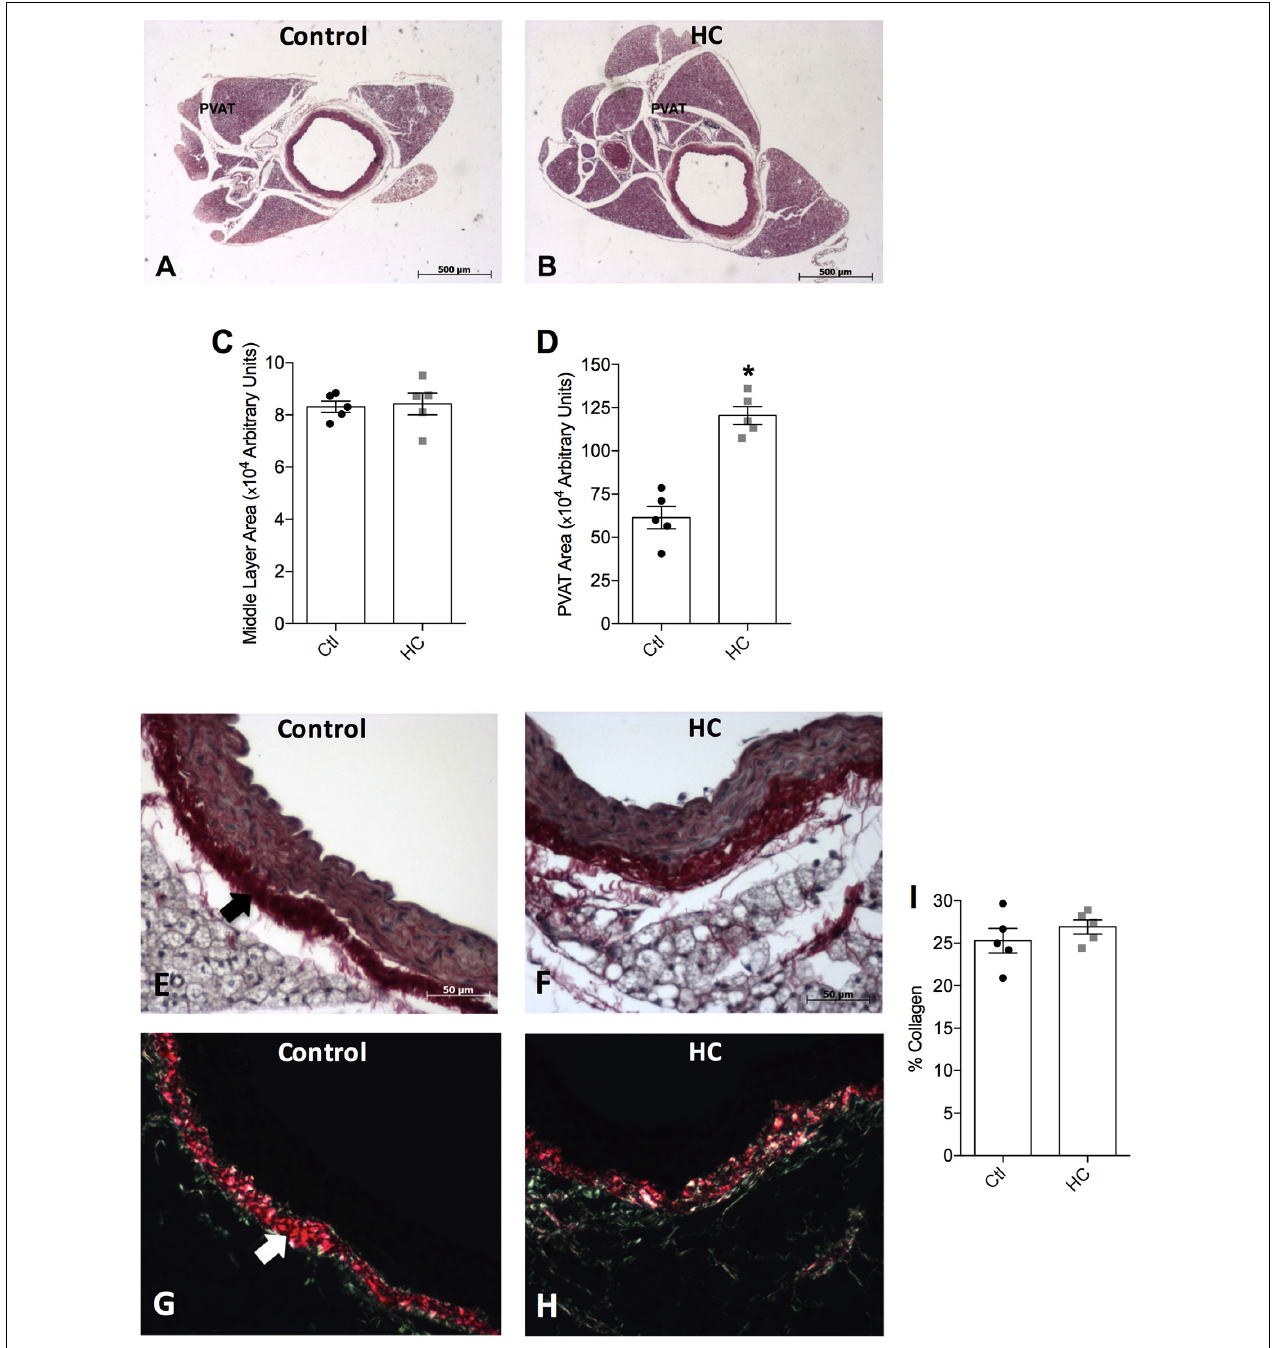
FIGURE 2 | Histological analysis of thoracic aorta and PVAT of control and HC groups. Representative histological sections stained by (A,B) hematoxylin-eosin, or picrosirius under the incidence of (E,F) normal polychromatic light or (G,H) polarized light. The areas of (C) middle layer or (D) PVAT, and (I) the percentage of collagen fibers are represented in graphical bars with mean ± SEM. The total number of animals required to carry out the experiments in each group ( n ) is presented in the dispersion points in the graphs. Statistical significance was determined using Student’s t -test. * p < 0.05 vs. control. Arrows indicate the abundance of collagen fibers in the adventitious layer of blood vessels. Scale bars indicate (A,B) 500 µ m or (E–H) 50 µ